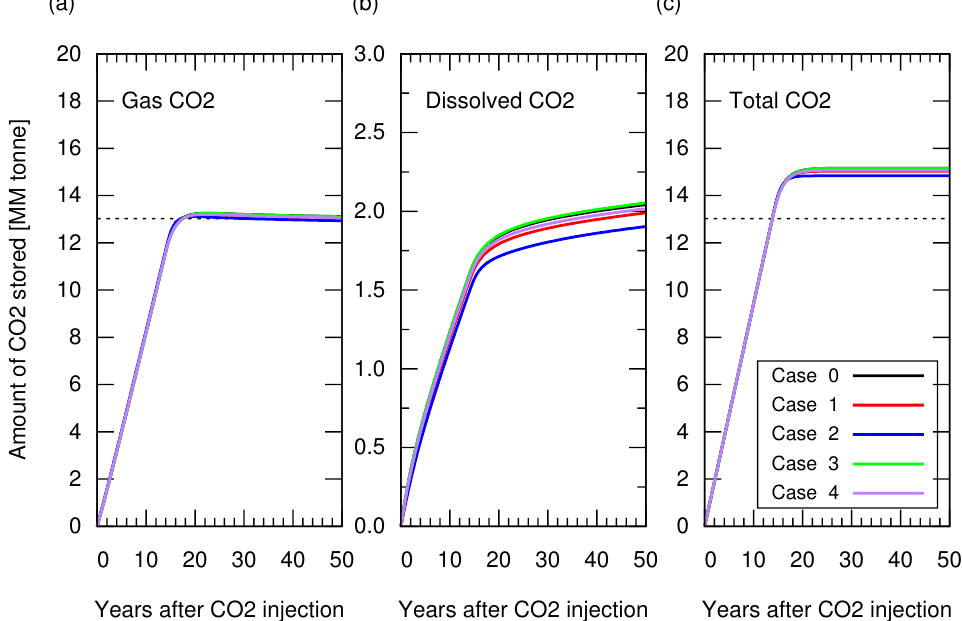
Figure 6. Amount of CO 2 stored in the reservoir for cases 0 to 4 as a function of years after CO 2 injection. ( a ) Structurally trapped CO 2 as a gas (super-critical) phase. All the lines from the five cases overlapped each other, showing a similar profile among cases; ( b ) CO 2 trapped as a dissolved component in water; ( c ) Total amount of trapped CO 2 (i.e., the sum of the structurally trapped CO 2 and the dissolved CO 2 ). The dotted lines in ( a ) and ( c ) indicate the CO 2 storage amount estimated from Equation